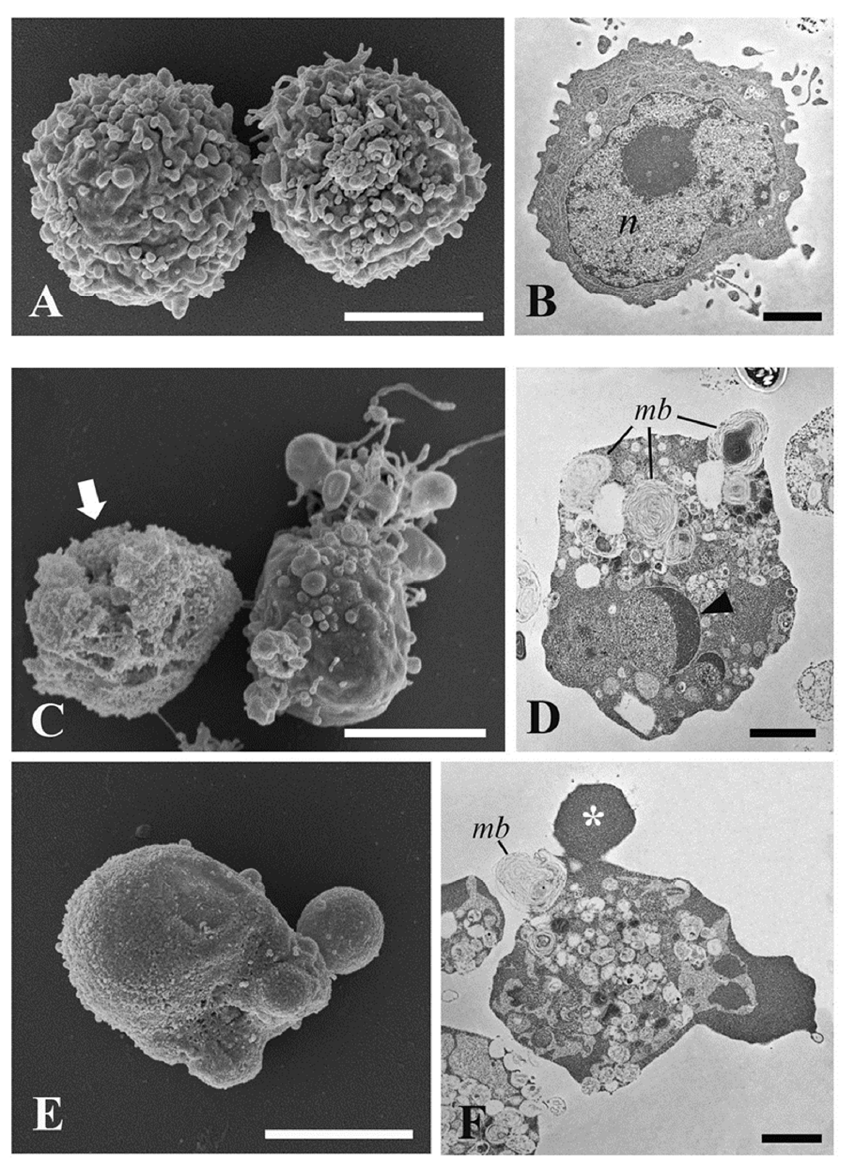
Figure 6. SEM and TEM investigations on HL60 cells. ( A ) SEM micrograph of untreated HL60 cells; ( B ) TEM micrograph of untreated HL60 cells; ( C , E ) SEM micrograph of puromycin-treated HL60 cells for 4 h; ( D , F ) TEM micrograph of puromycin-treated HL60 cells for 4 h. n , nucleus; mb , multilamellar bodies; arrow, dead cell; asterisk, fragmented nucleus. Bars = ( A , C , E ) 5 μm; ( B , D , F ) 2 μm.